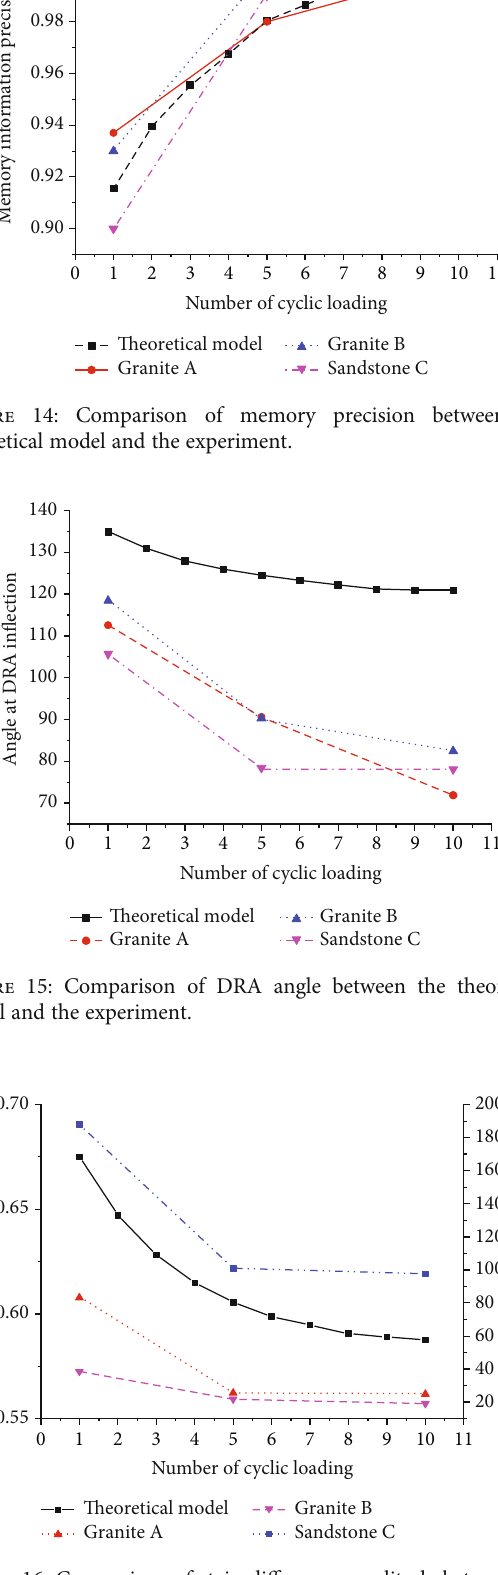
Figure 16: Comparison of stain di ff erence amplitude between the theoretical model and the